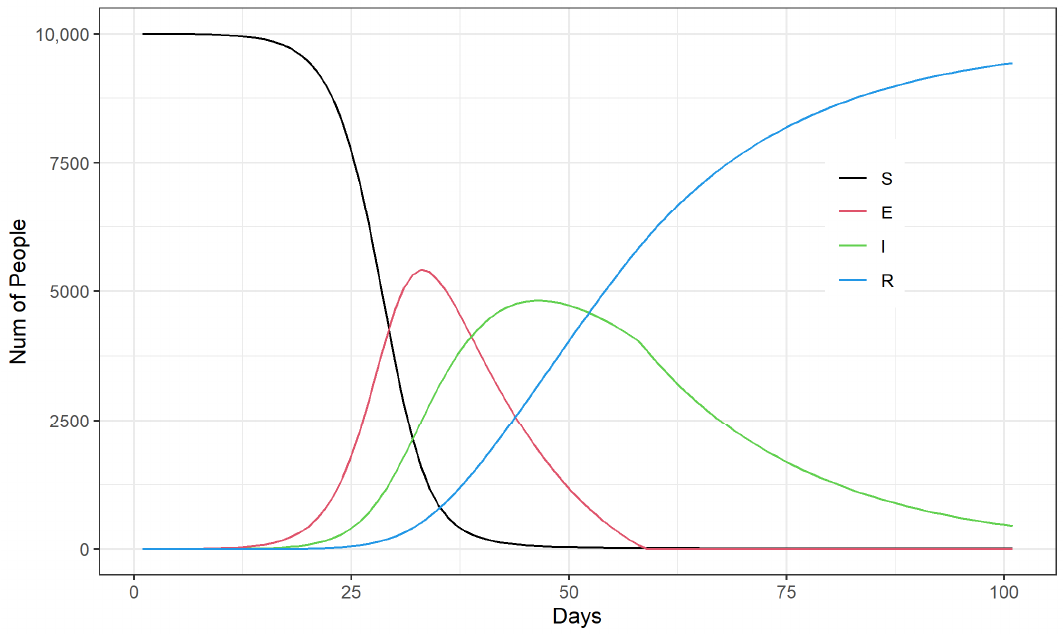
Figure A2. The influence of the daily testing capacity of 100 person on the evolutionary process of the epidemic; (The unit of the ordinate is “person”).